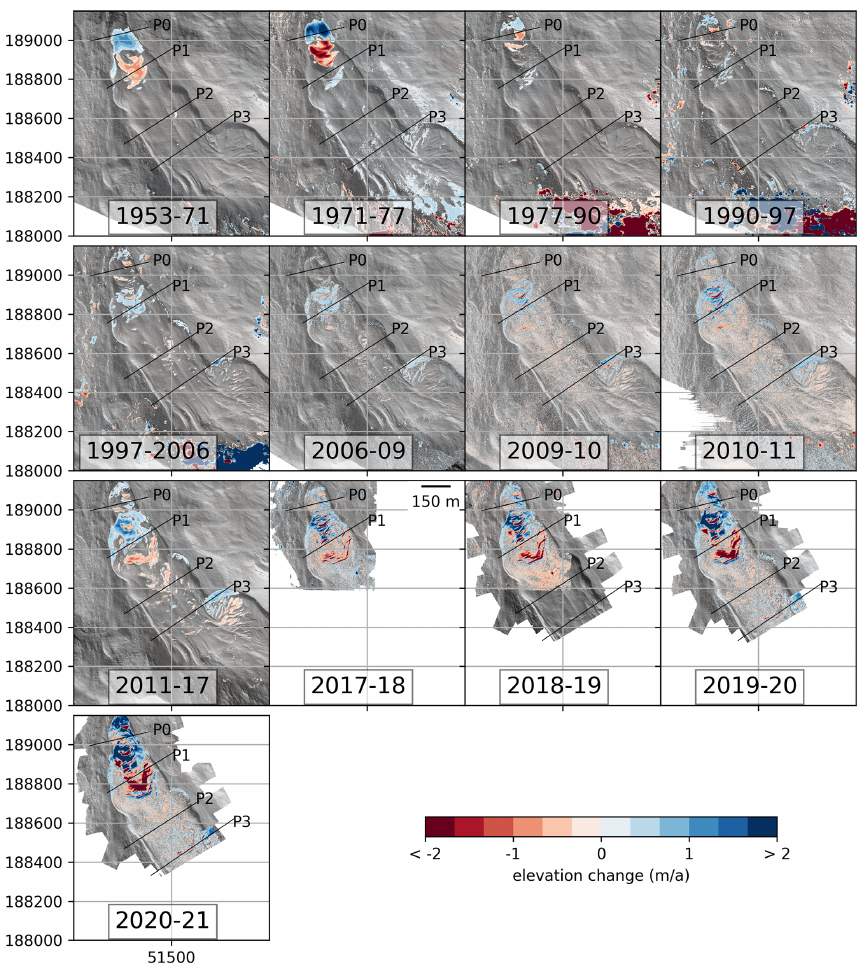
Figure 9. Vertical surface elevation change (ma − 1 ) beyond the individual uncertainty (Table 2) for the time series of DSM pairs, plotted over hillshades of the latter DSM of each pair. High change values in the steep rock face above the root zone of the rock glacier are artefacts from the photogrammetric processing due to shadows and/or snow cover in the images and are included for the sake of transparency. Reference lines defining block profiles P0–P3 are added for orientation purposes (coordinate grid: